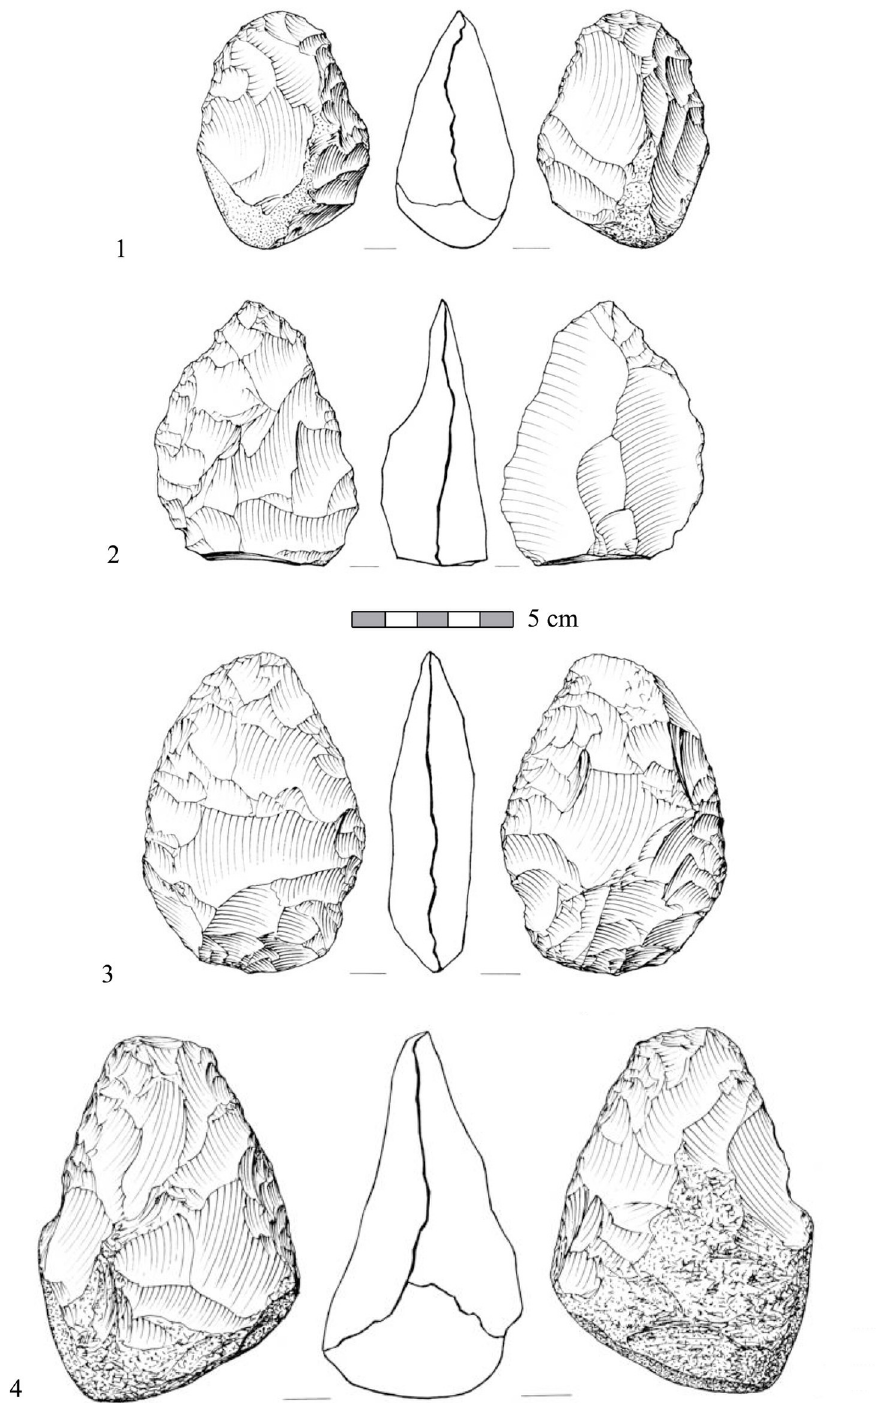
Fig 10. Typical bifacials from the assemblage of Area B in Jaljulia. 1, 3–4) Handaxes. 2) A handaxe with preferential flake scars.